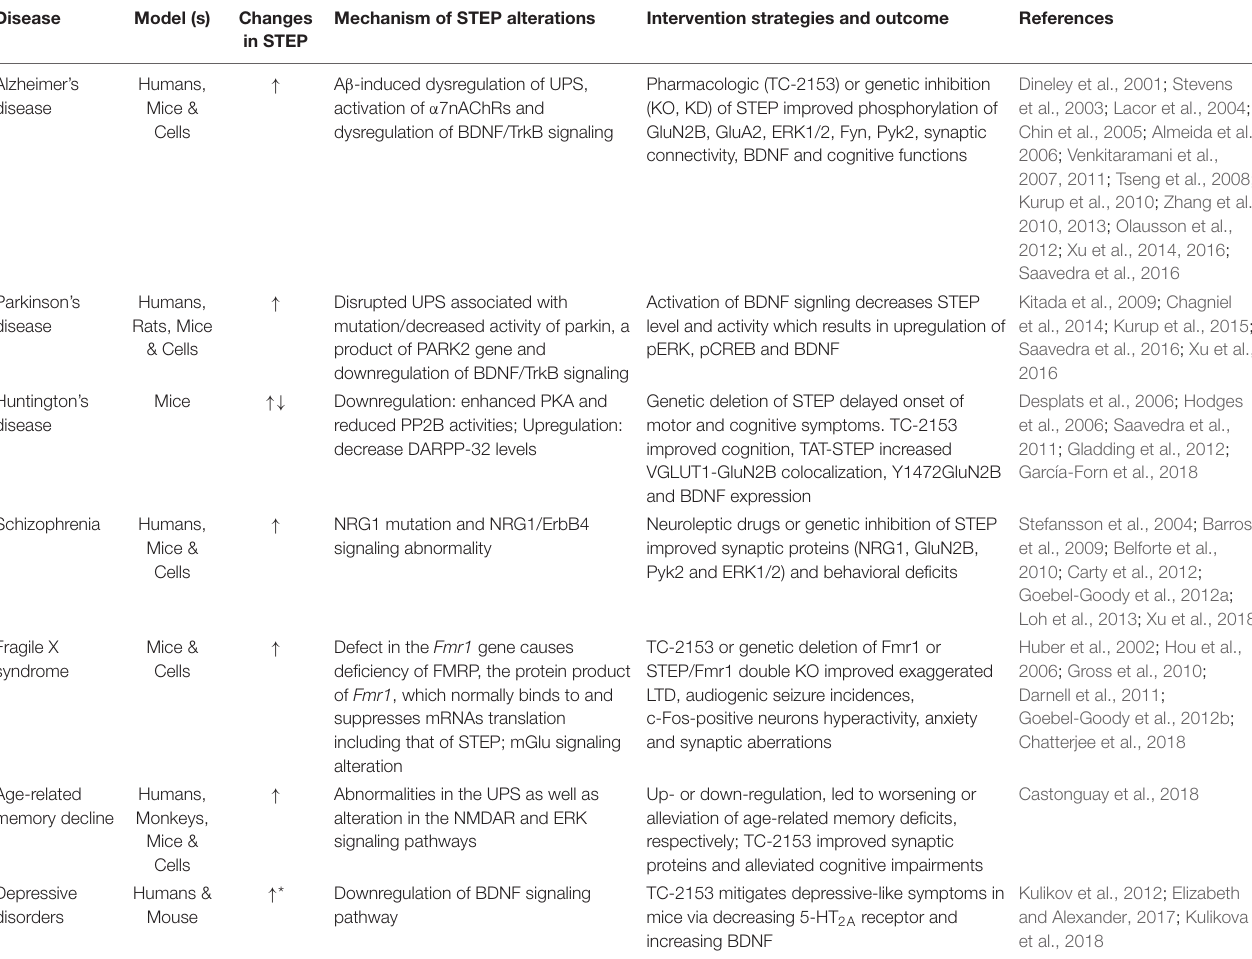
TABLE 2 | STEP alteration mechanisms in neurological disorders and the therapeutic